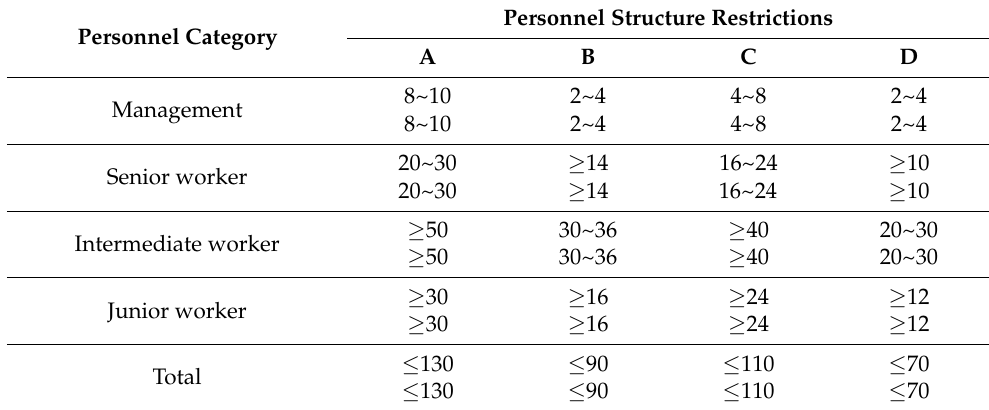
Table 4. Personnel structure restrictions of each bridge and tunnel operation and maintenance unit.